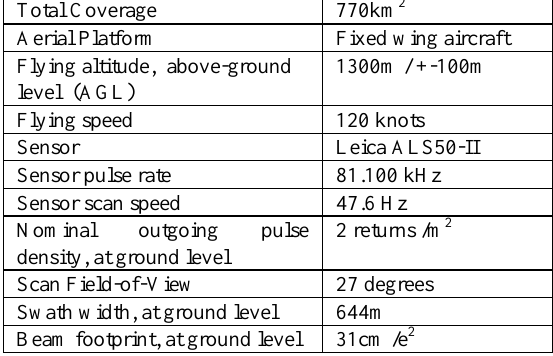
Table 2. Airborne LiDAR Scanning